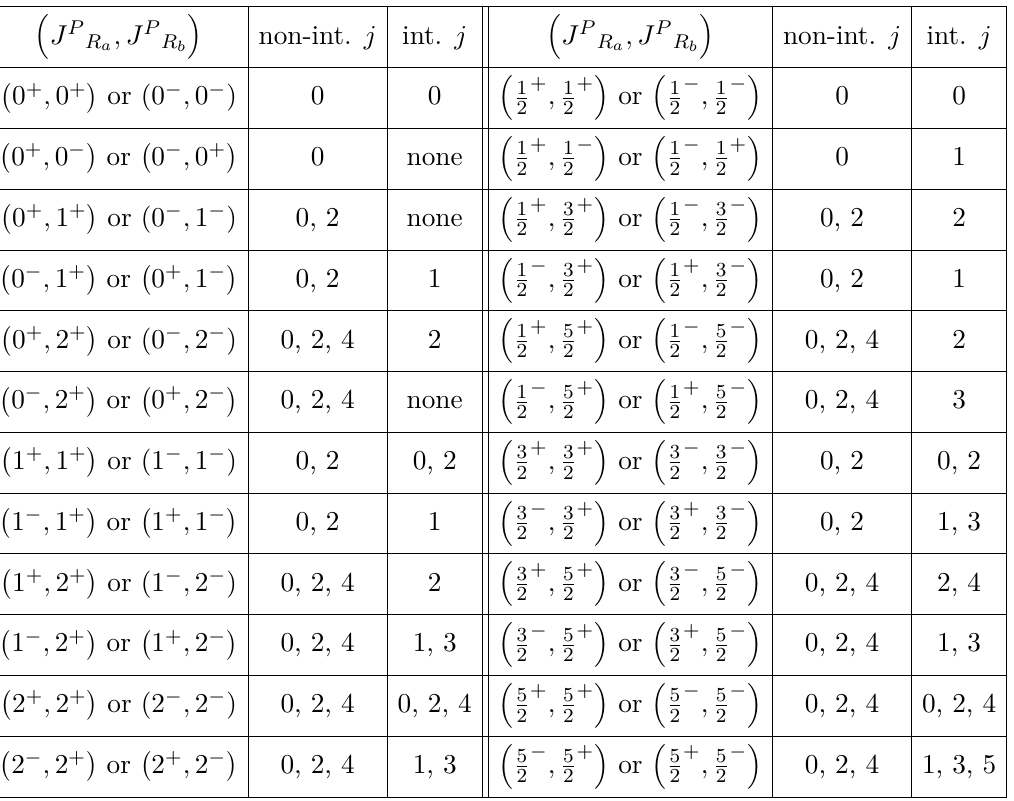
Table 1 . The values of j for which the non-interference and interference terms appear in w ( j ) and ¯ w ( j ) according to SRs in the cases of integer and half-integer spins of R a and R b